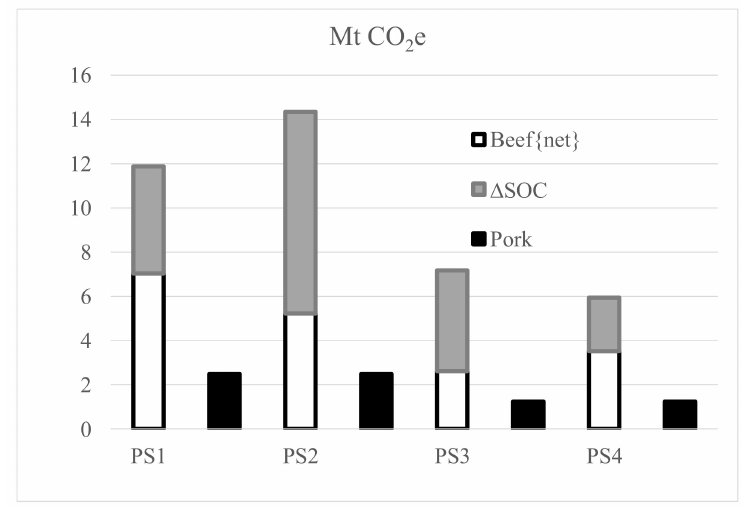
Figure 5. Comparison of changes in soil organic carbon ( ∆ SOC) and net beef GHG emissions (Beef(net)) with GHG emissions from pork production (Pork) for four production scenarios (PS) based on reduced red meat consumption in